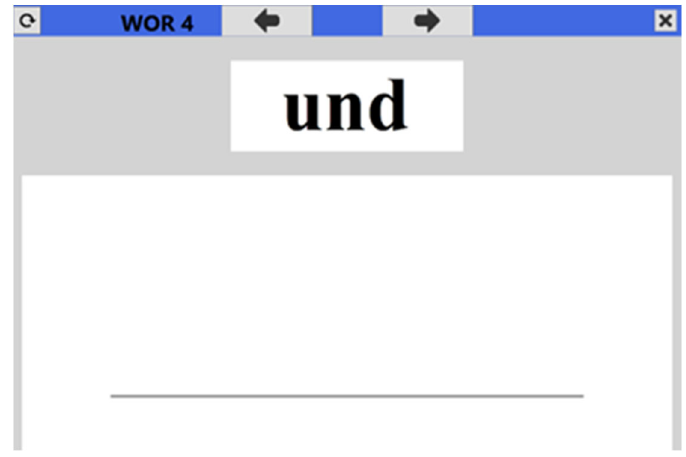
Figure 4. Screenshot of item (item 4 “und”) and response line (for children).